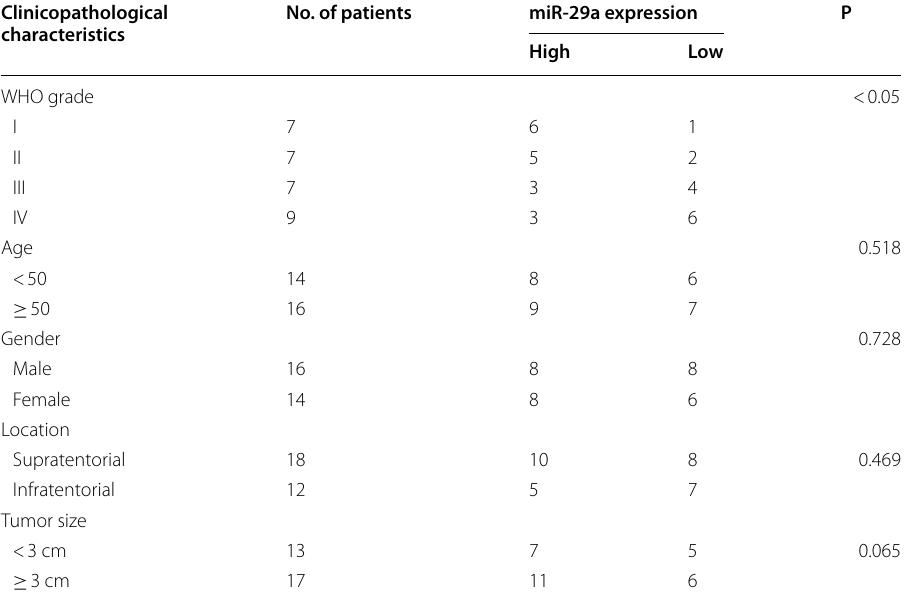
Table 1 The association between miR-29a expression and clinicopathological characteristics of included